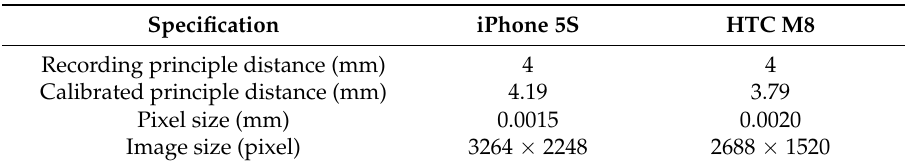
Table 1. The official specifications of the smartphone